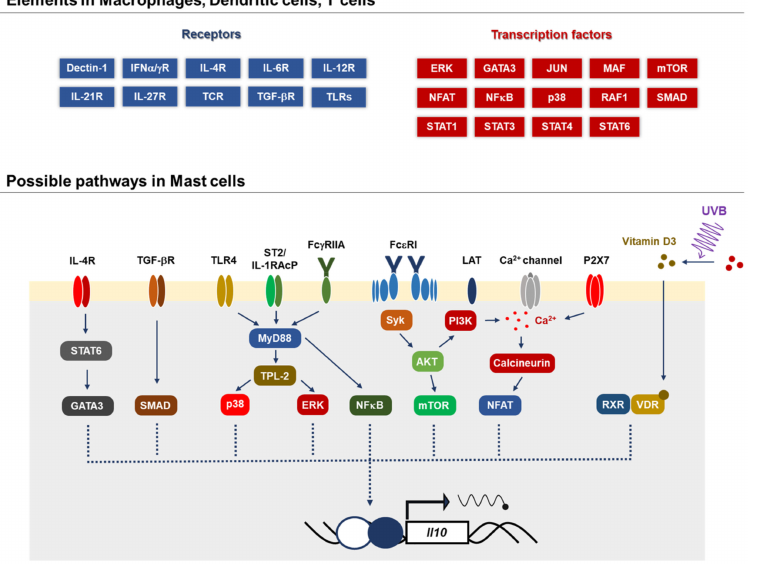
Figure 3. Possible mechanisms by which MCs produce IL-10. Several signal-transducing molecules and transcription factors, GATA, Smad, p38, ERK, NFkB, mTOR and NFAT, have been identified to contribute to IL-10 production in various immune cells. The molecular mechanism by which MCs pro- duce IL-10 is largely unknown, whereas a few pathways have been reported: 1a,25-dihydroxyvitamin D 3 and the IgE signaling-dependent pathway in the skin [70] and IL-33/ST2 and IgG/Fc γ RIIA in rheumatoid arthritis